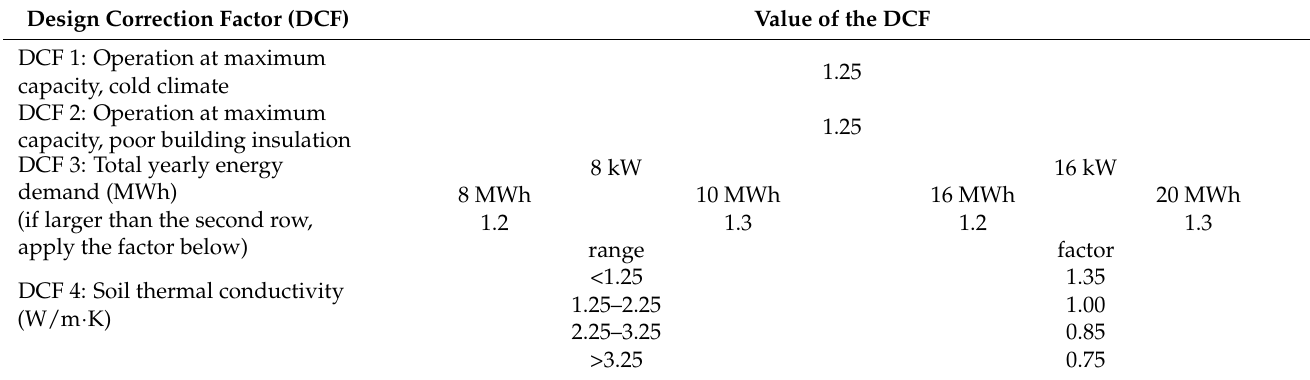
Table 5. Design correction factors (DCFs) for different governing parameters